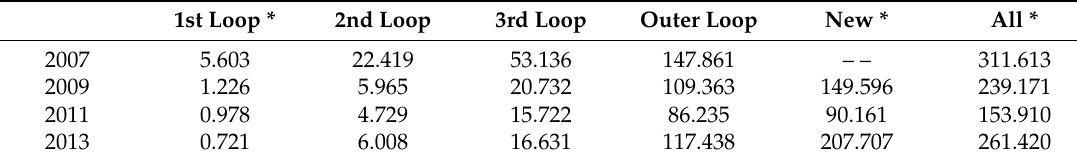
Table 3. The distribution of bare lands (km 2 ).